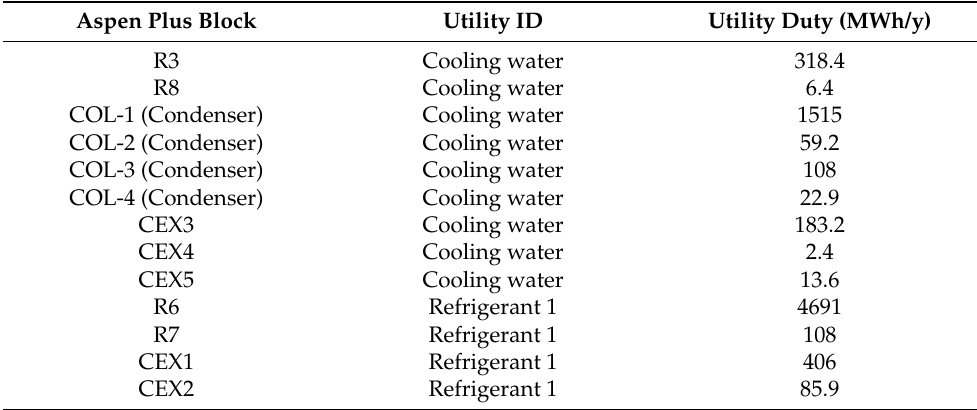
Table 8. Summary of energetic requirements satisfied with the